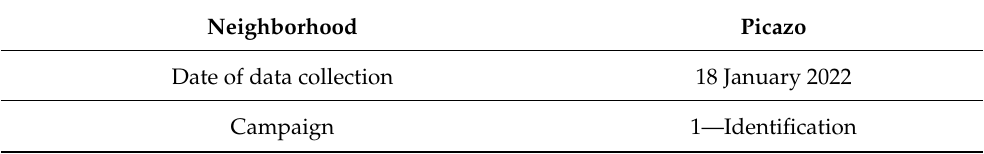
Table 1. Representative information sheet obtained from the experimental campaigns.